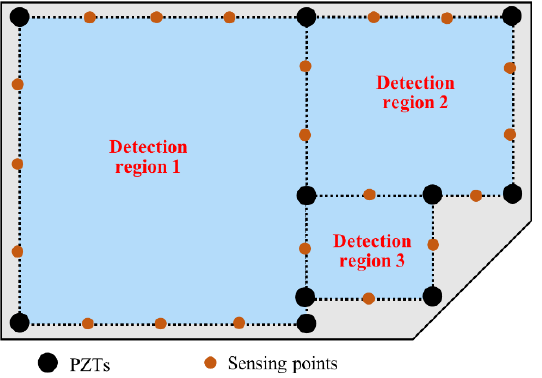
Figure 12. The proposed arrangement of detection regions in practical inspection of a large plate.